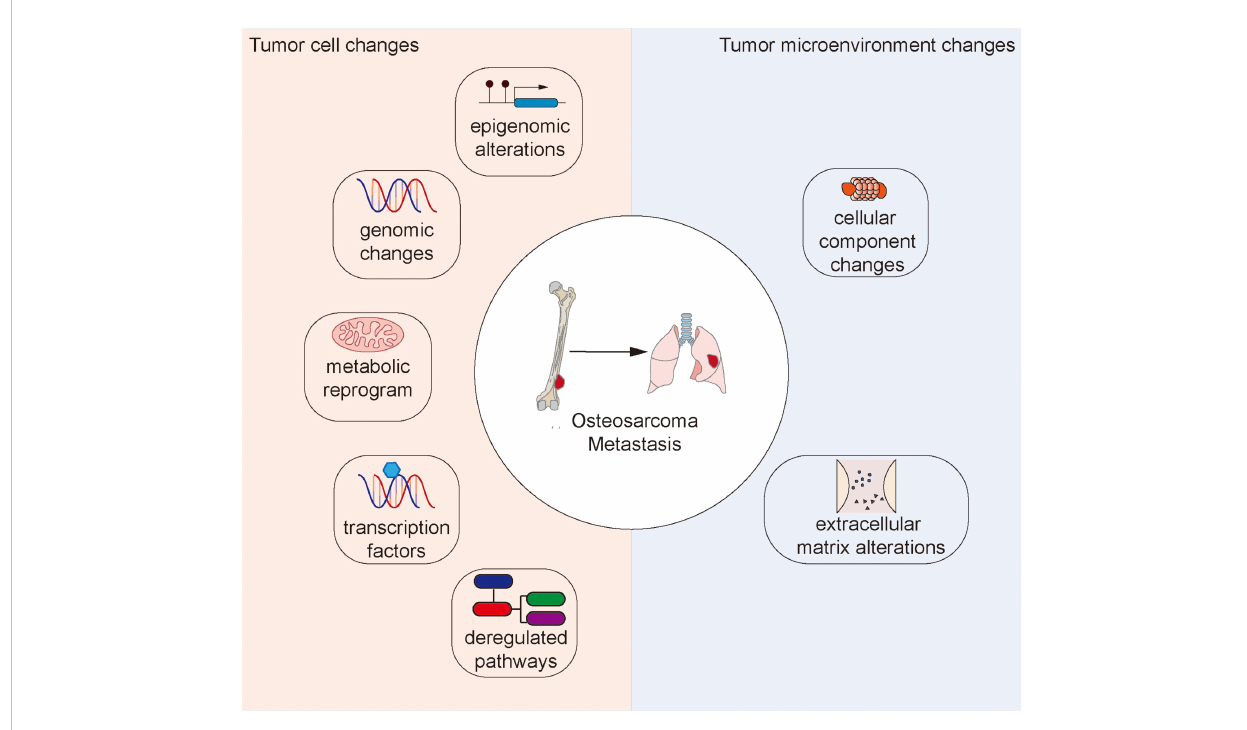
FIGURE 1 Changes to the tumor cell and tumor microenvironment that facilitate osteosarcoma